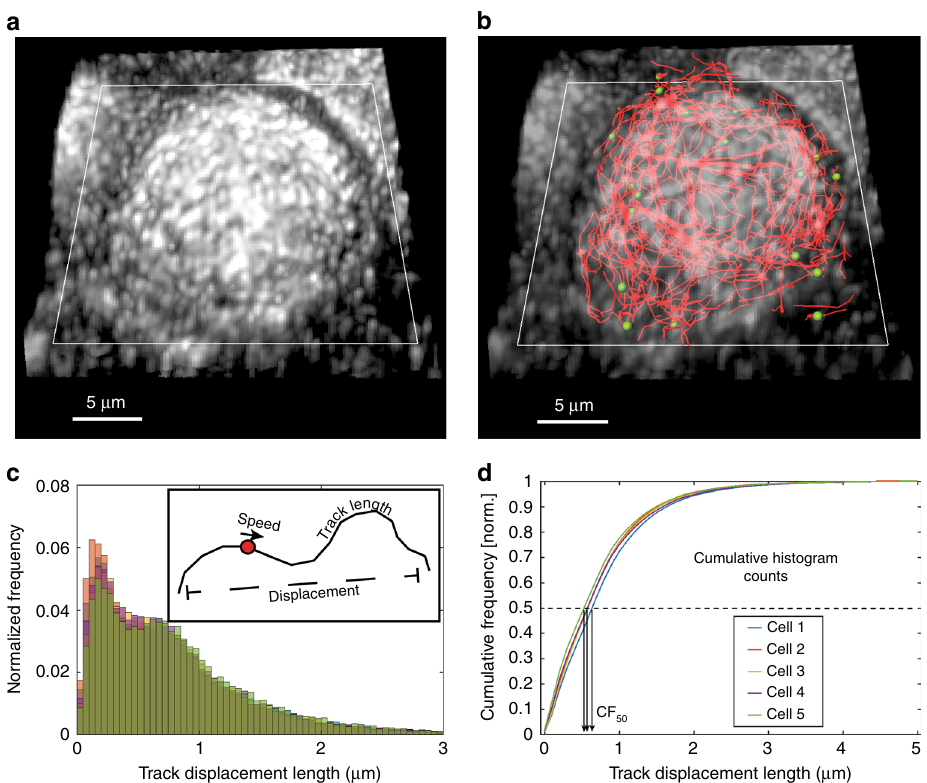
Fig. 1 Work fl ow to analyze intracellular motion in three dimensions (3D). a Dual-view volumetric images are fused and deconvolved to obtain a single volumetric image with ~330-nm isotropic resolution 23 . Here, a diSPIM maximum intensity projection is shown for a WSN-infected A549 cell stably expressing GFP-tagged Rab11A (GFP-Rab11A). The coverslip plane (white rectangle) is also indicated. b Fluorescent puncta are identi fi ed and tracked over time in Imaris. For clarity, only tracks with displacement >2 μ m are shown (red lines). Green spheres show GFP-Rab11A spot centers from a single